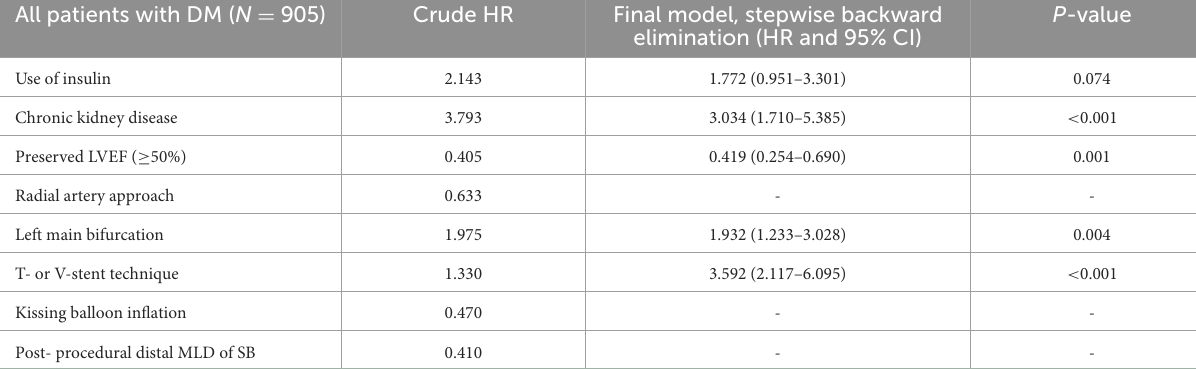
TABLE 2 Independent predictors of 5-year target lesion failure in DM patients treated for coronary bifurcation lesion with stent implantation. All patients with DM ( N =